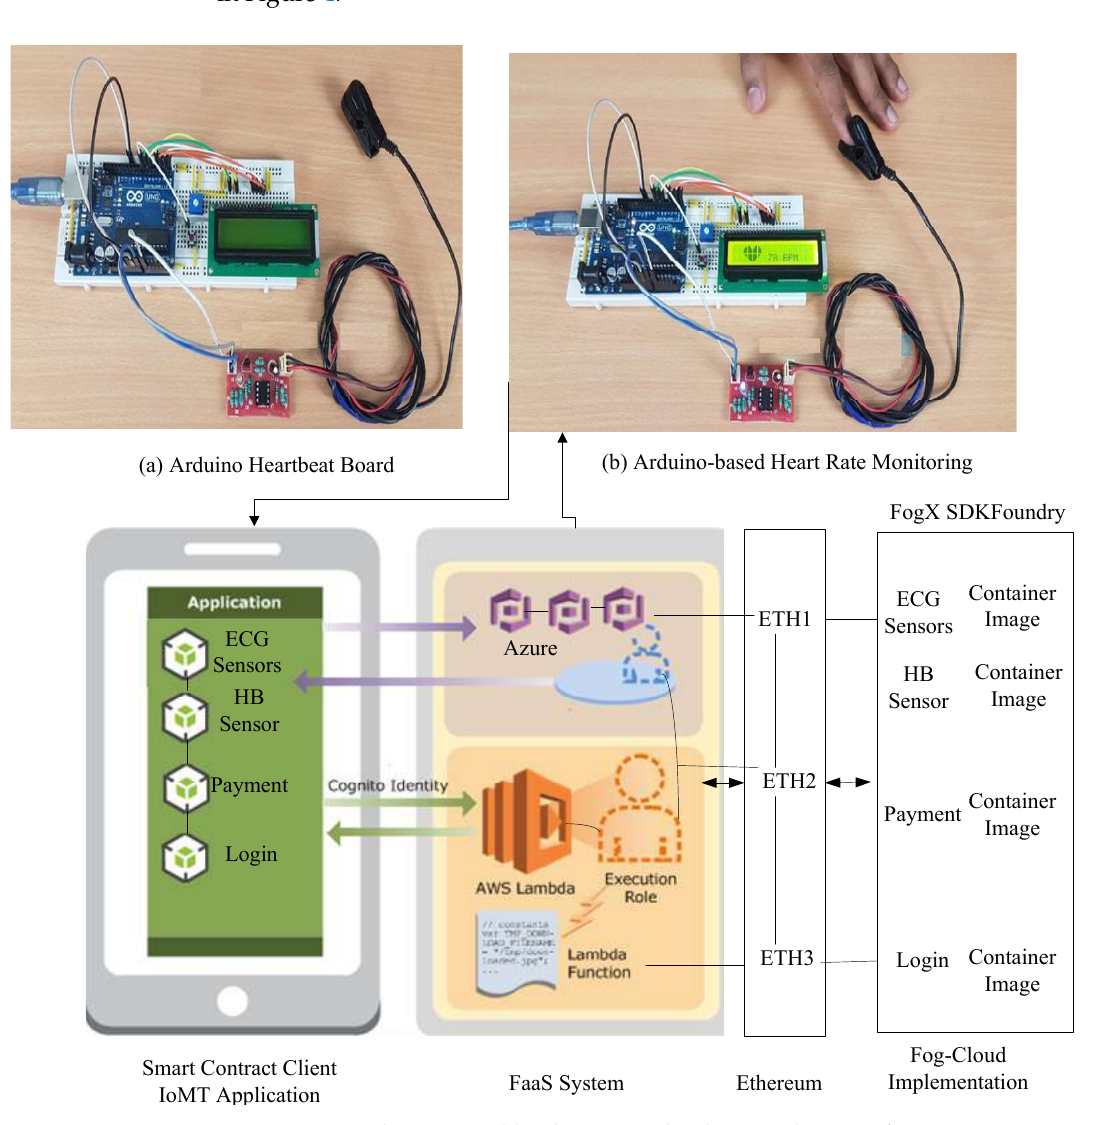
Figure 4. Smart-Contract-Ethereum Enable Client-Fog-Cloud Assisted System for